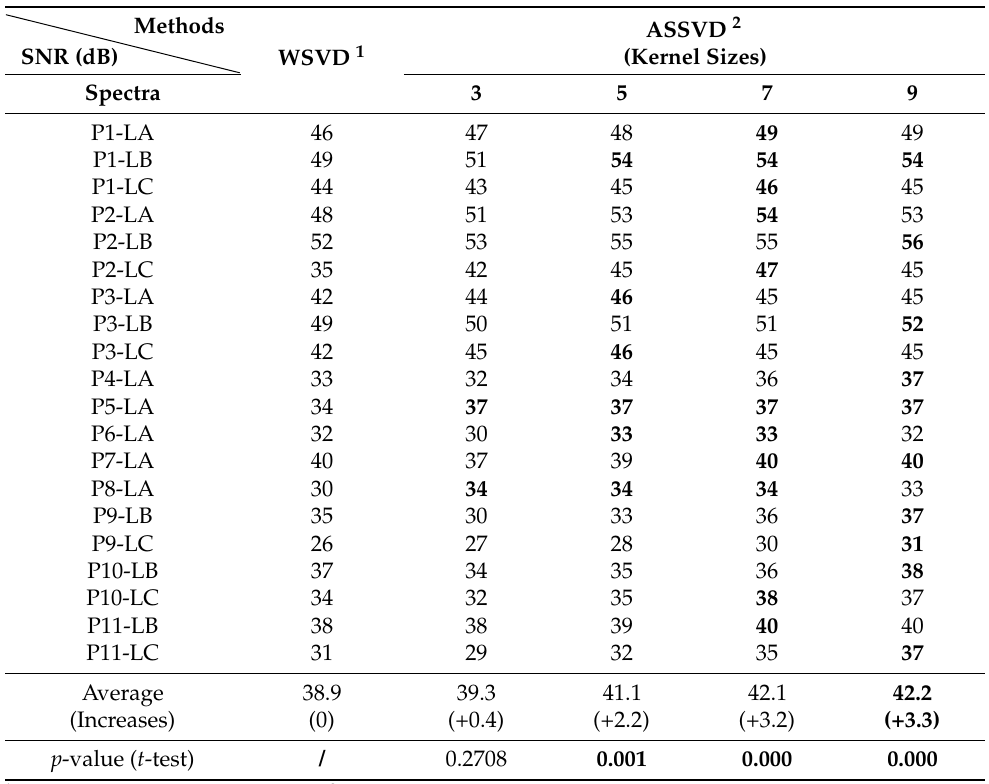
Table 3. Influence of SNR with the different kernel sizes in